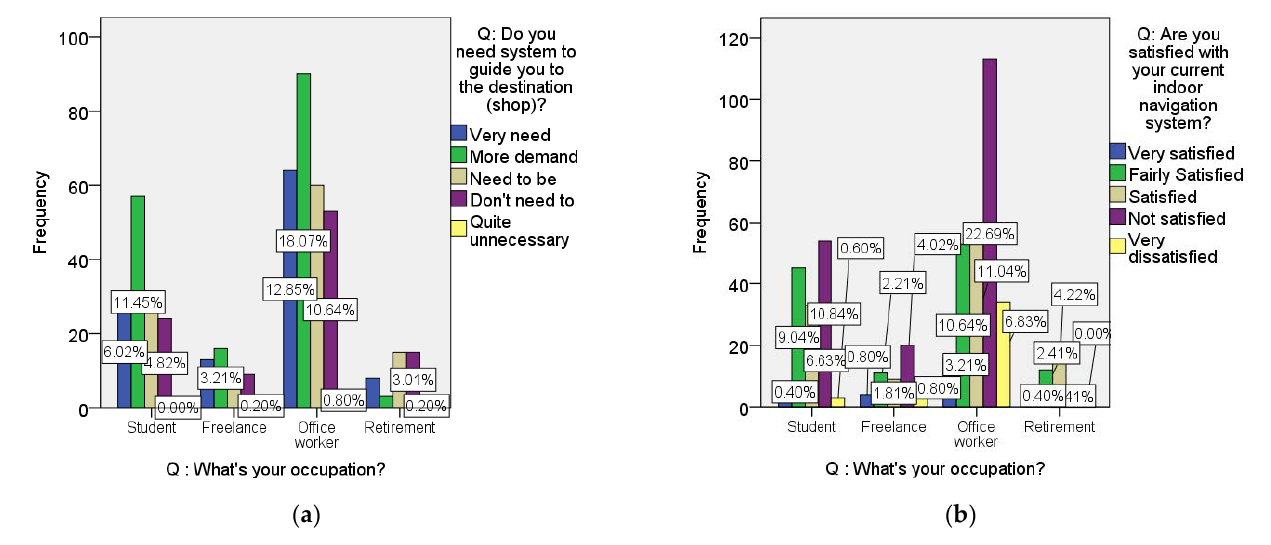
Figure 16. Frequency comparison of “ Occupation ” and personal data related to shopping behavior.